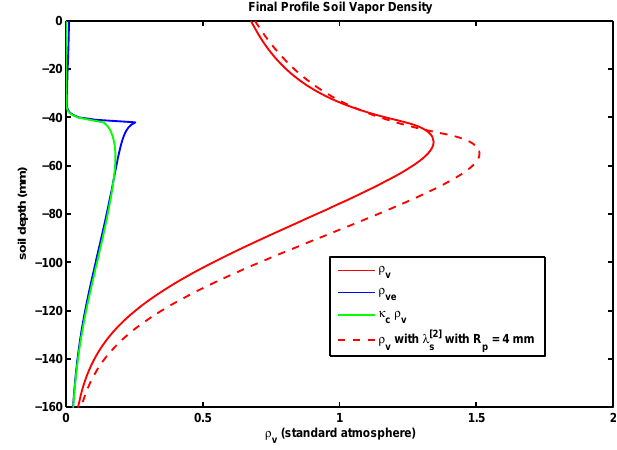
Figure 7. Final modeled profiles of vapor density [ ρ v ], equilibrium vapor density [ ρ ve ], and the condensation coefficient ( K c ) modified vapor density term [ K c ρ v ] used with the non-equilibrium model source term, S v , at the completion of the 90min model simulation. The three solid lines are for a model simulation with R p = 1mm; the single dotted line corresponds to a simulation with R p = 4mm. The maximum vapor density for these two simulations is between about 1.3 and 1.5 times the density of the standard atmosphere (i.e., 1 . 292kgm − 3 ) and is located near the position of the maximum in the vapor source term, S v . This figure can be compared with the equilibrium model result: Fig. 8 of Massman